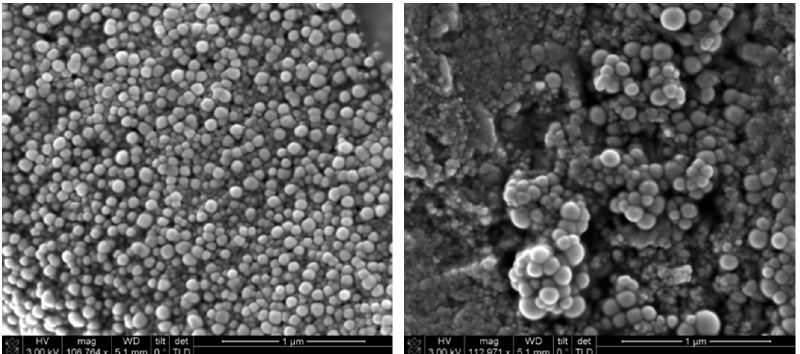
Figure 3. SEM image of AgNPs ( left ) and PPFS coupled AgNPs (PPFS@AgNPs) ( right ).